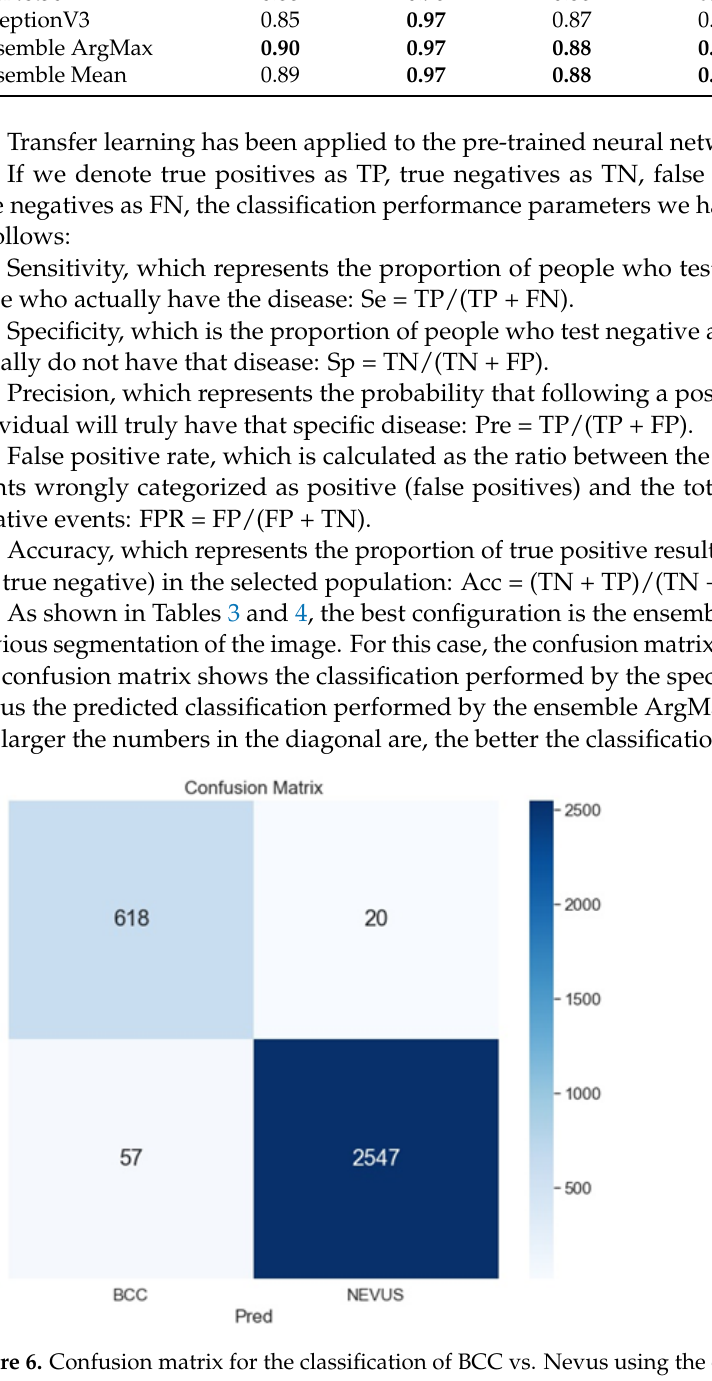
0.95 The best result is obtained for the ensemble ArgMax without previous segmentation; the confusion matrix for this case is shown in Figure 7.